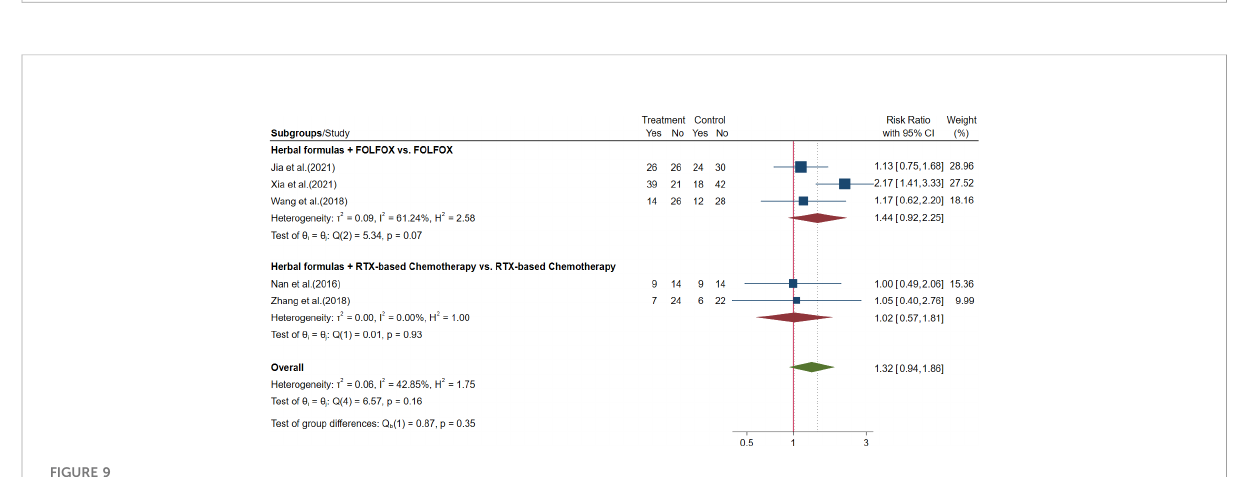
FIGURE 9 Forest plot of objective response rate (ORR) in advanced colorectal cancer